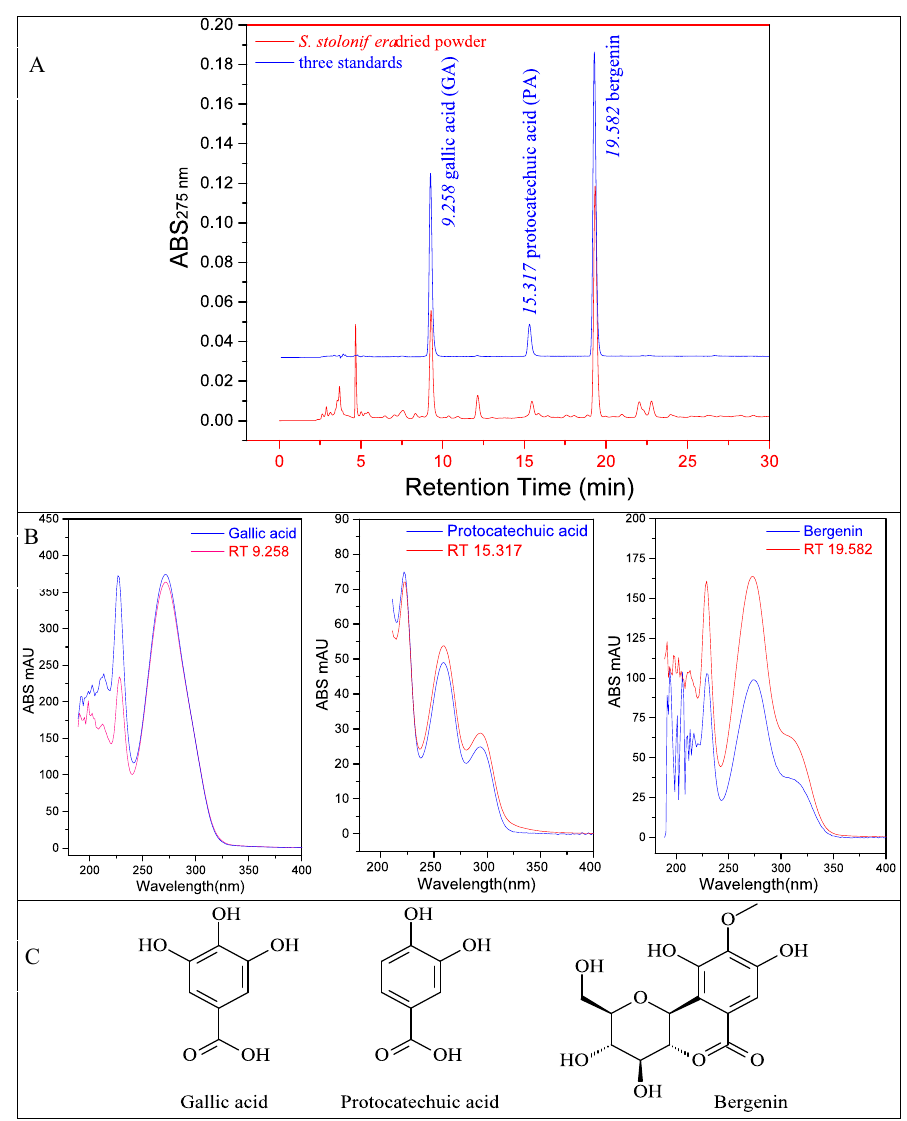
Fig. 2: HPLC-DAD patterns of three standards (GA, PA and bergenin) and the main components in S. stolonifera (A). UV spectra (B) and their molecular structures (C) of three standards and three peaks in S. stolonifera . RT: retention time of three peaks in HPLC-DAD.